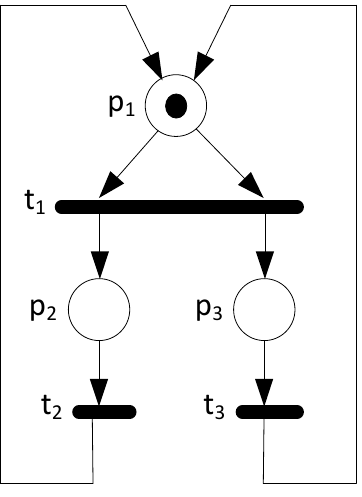
Figure 6. An exemplary unbounded Petri net.